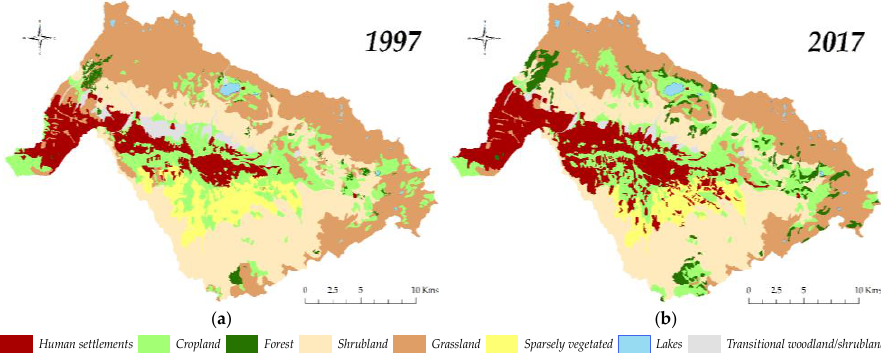
Figure 4. Land use types in the Rocha River catchment in ( a ) 1997 and ( b ) 2017 (adapted from Gossweiler et al. [24]).